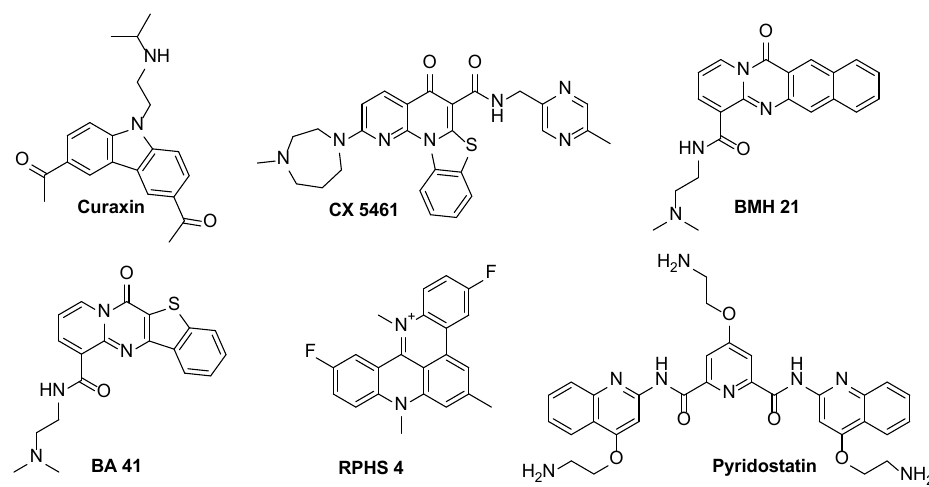
Figure 1. Structures of selected G-quadruplex binders.